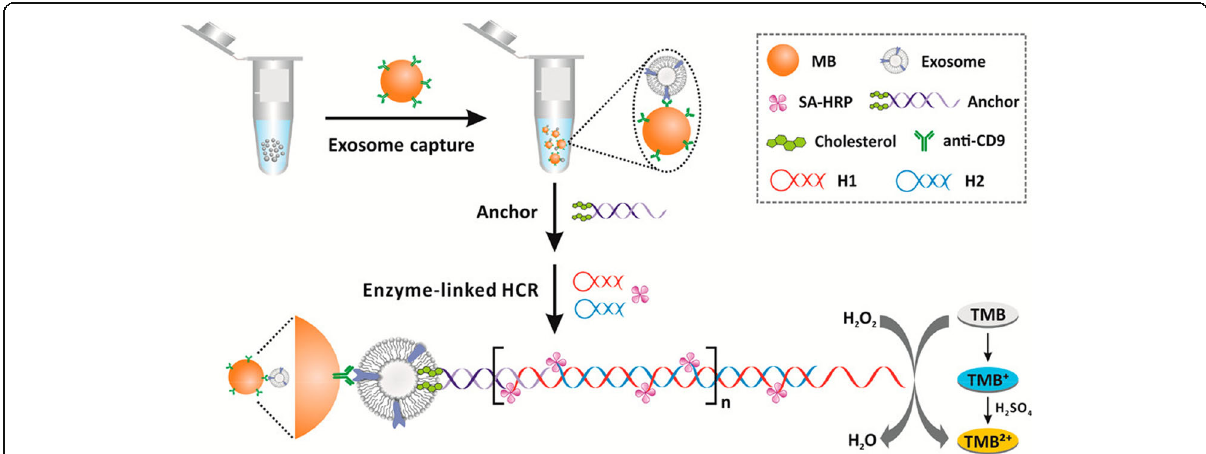
Fig. 4 Exosome quantification by a method based on immunoaffinity separation combined with cholesterol signal amplification [135]. Copyright© 2017, American Chemical